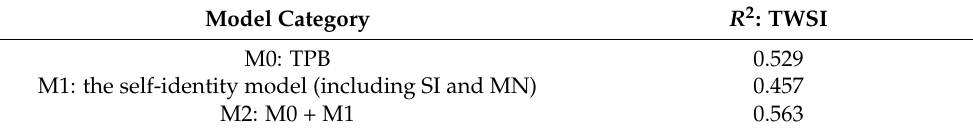
Table 6. Model comparison test